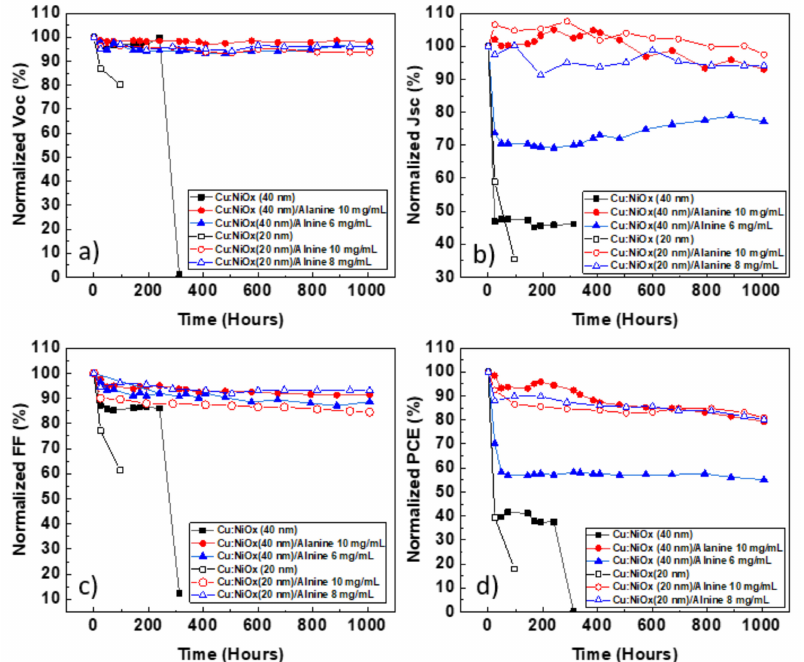
Figure 3. Lifetime plots of normalized: ( a ) V oc , ( b ) J sc , ( c ) FF , and ( d ) PCE under accelerated heat conditions.